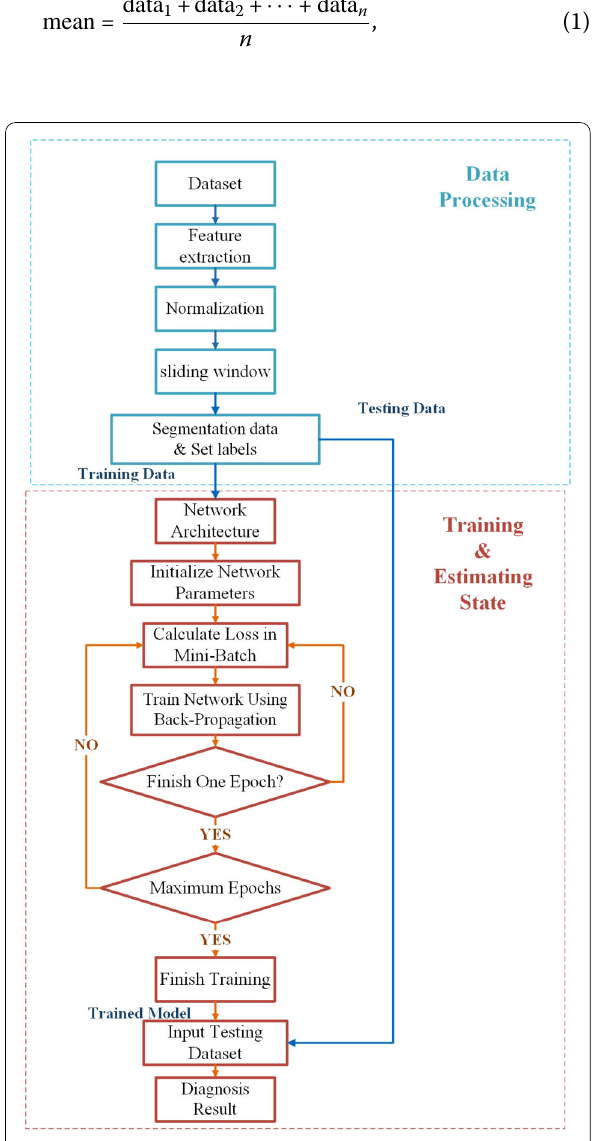
Figure 1 Flow chart of the DMA-CNN based robotic fault